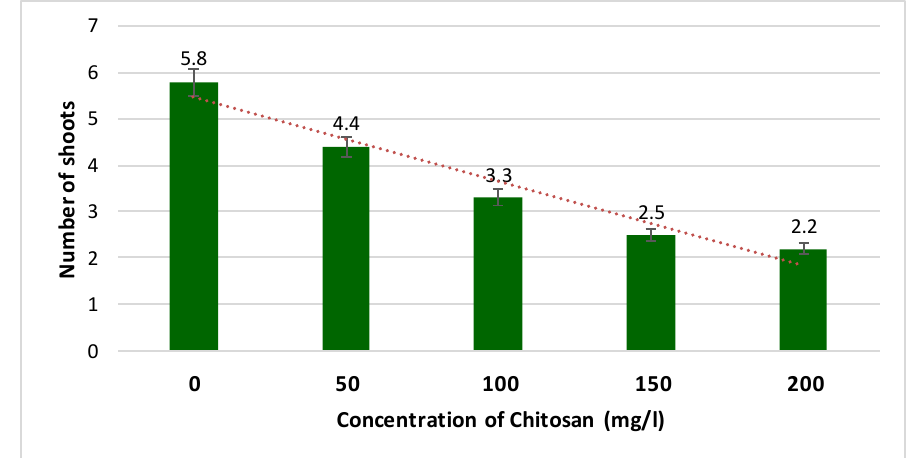
Figure 2a. Shoot multiplication in in vitro shoots of C. nutans in different concentrations of chitosan